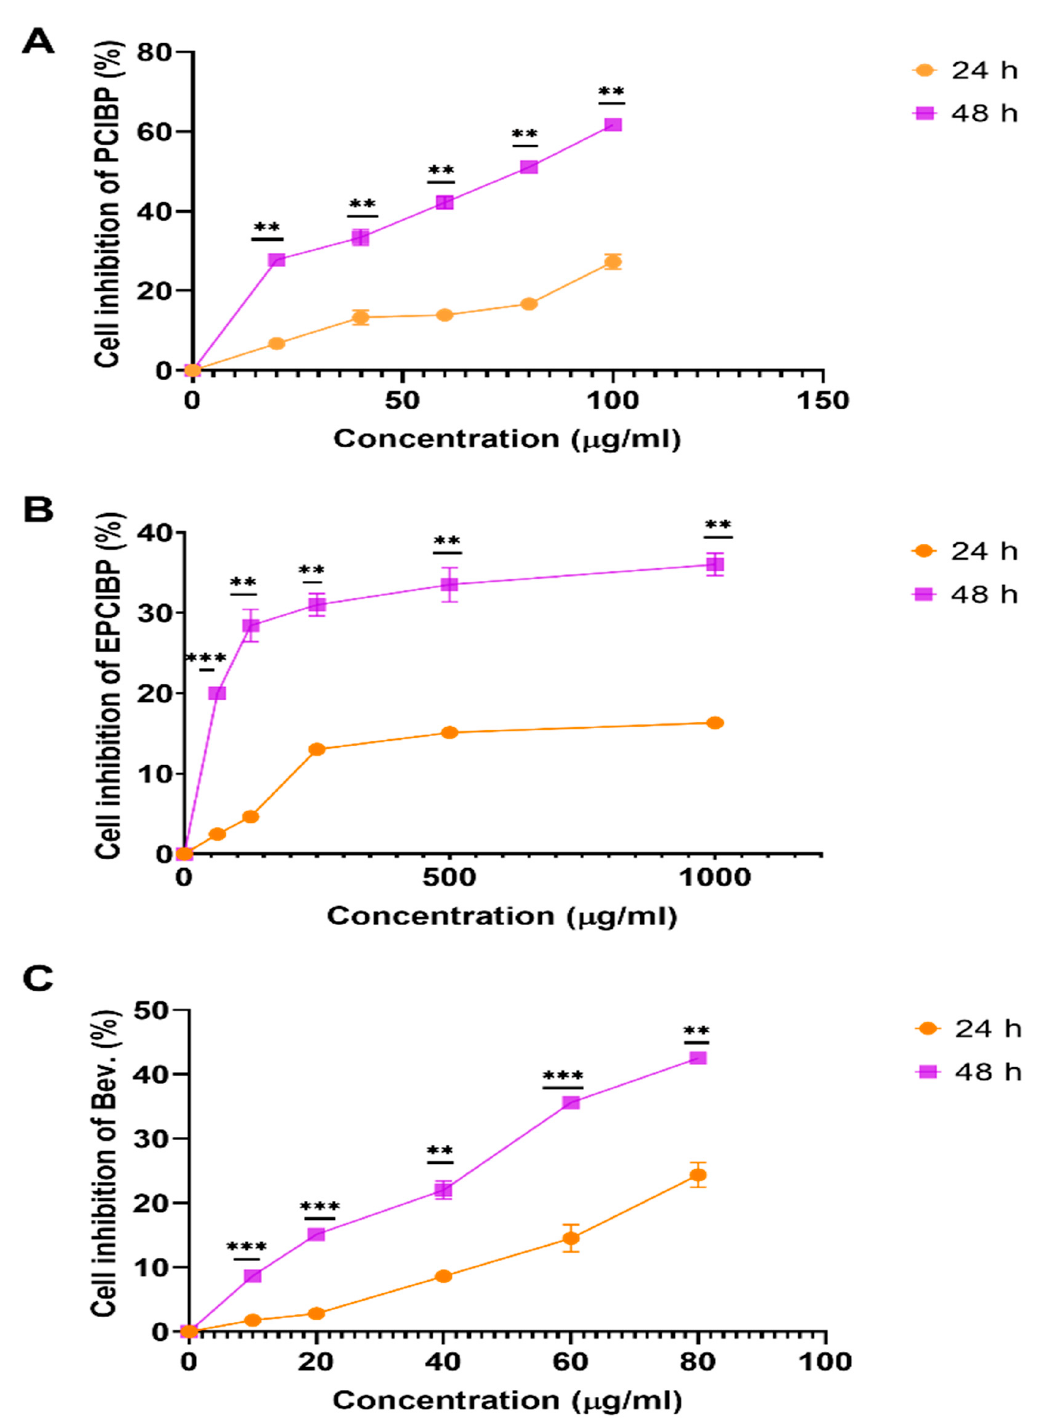
Figure 8. Line graph of the cell inhibition results on Vero normal cells after incubation for 24 and 48 h with PCIBP, EPCIBP, and Bev. treatments. The percentage of treated cells was measured by MTT cytotoxicity assay. ( A ) PCIBP for each point compared with the other points by multiple t -tests where ** p ≤ 0.001; ( B ) EPCIBP for each point compared with the other points by multiple t -tests where ** p ≤ 0.001, *** p < 0.0001; ( C ) Bev. for each point compared with the other points by multiple t -tests where ** p ≤ 0.001, *** p ≤ 0.0001.